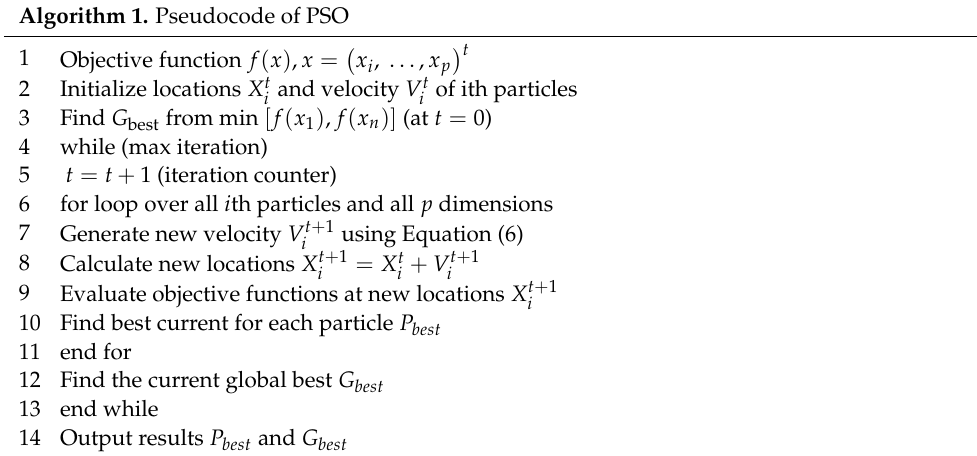
Algorithm 1. Pseudocode of